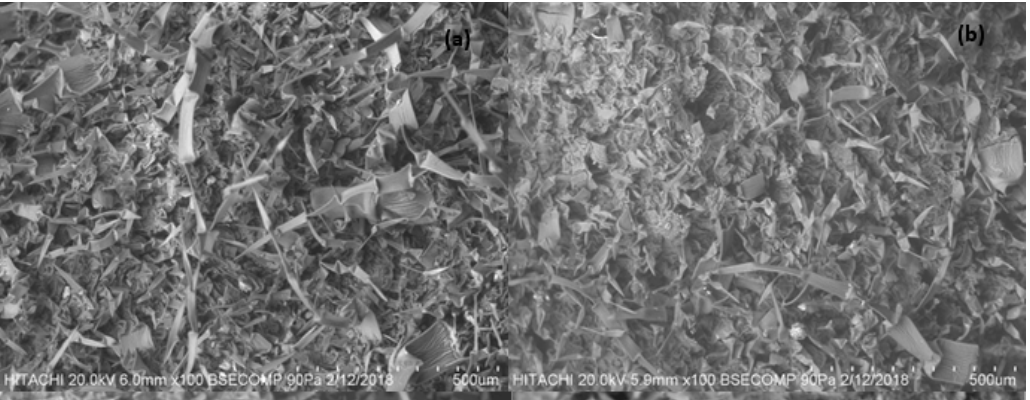
Figure 6. SEM image of raw P . amboinicus leaves.